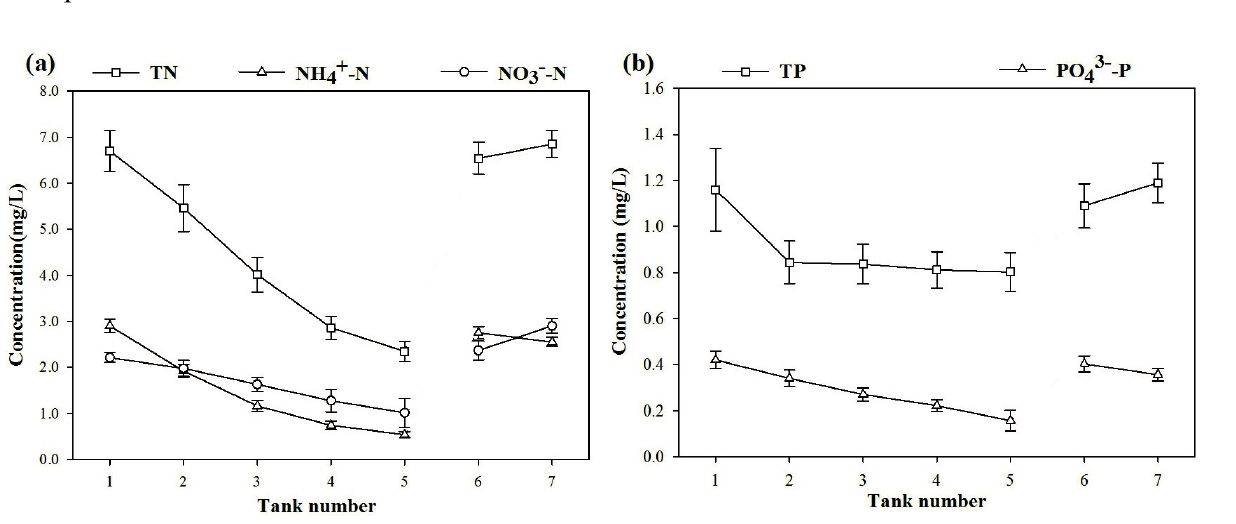
Figure 2. Average nitrogen ( a ) and phosphorus ( b ) indexes and their standard deviation along